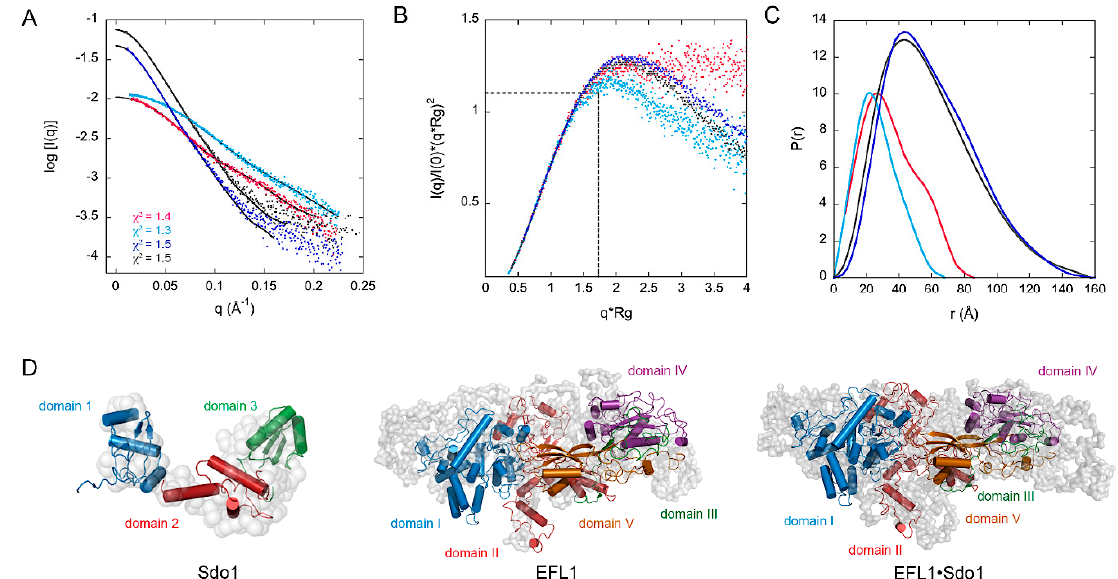
Figure 3. Solution structure of the yeast proteins Sdo1 and EFL1 alone and in complex. ( A ) Experimental scattering curves compared to the fit (solid traces) of the simulated curves calculated from homology models. ( B ) Dimensionless Kratky plot. The intersection of the dotted black trace corresponds to the value for bovine serum albumin. ( C ) Pair-distance distribution function plot, P(r). Color codes correspond to magenta—Sdo1, light blue—Sdo1 domains 2–3, grey—EFL1, and dark blue—Sdo1 • EFL1 complex. ( D ) Low resolution Small Angle X-ray Scattering (SAXS) envelopes of the studied proteins, showing the corresponding fitted homology models.